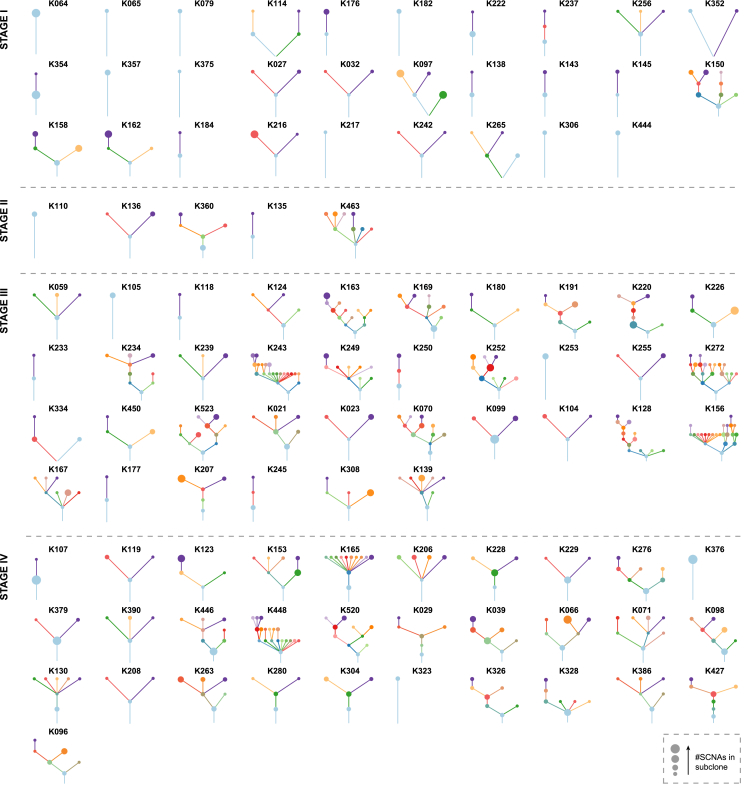
Driver Phylogenetic TreesDriver phylogenetic trees for each tumor (or multiple tumors from the same patient) are shown. The trees are ordered by the overall tumors stage: I–IV. The founding clone is indicated in light blue, with subsequent sub clones shown in distinct colors. The size of each node represents the number of SCNAs detected within that subclone. The length of lines connecting tumor subclones does not contain information.See also Data S2.